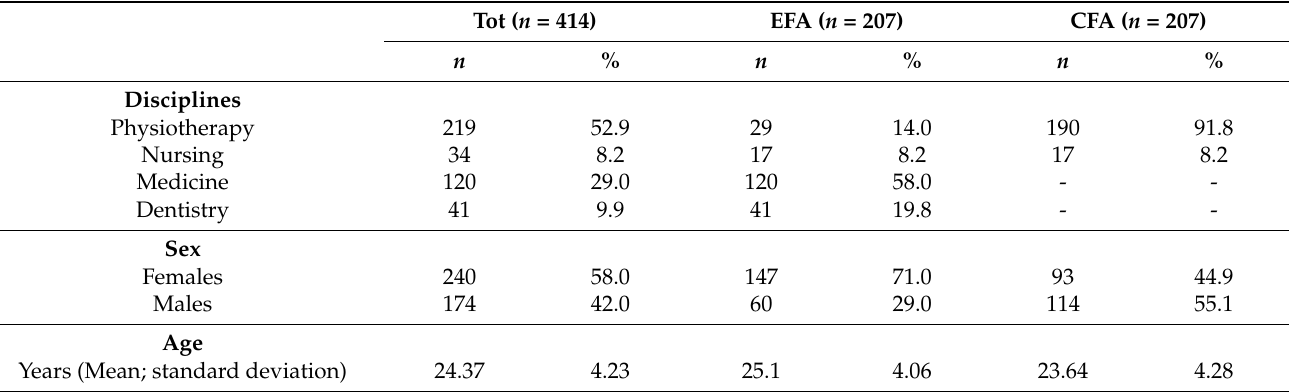
Table 3. Characteristics of the responders ( n =